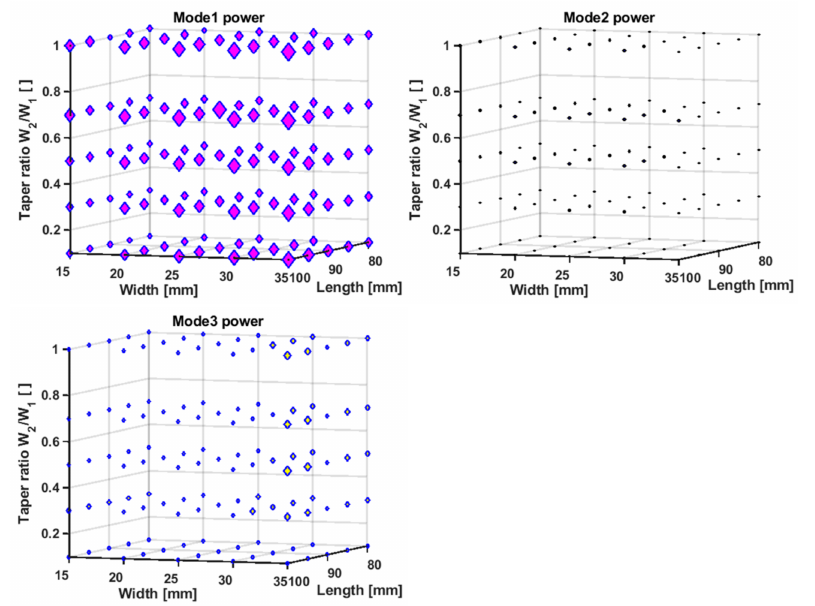
Figure 10. Tendency graphs for the power of the first three resonant modes of a multimode bimorph segmented tapered cantilever-based